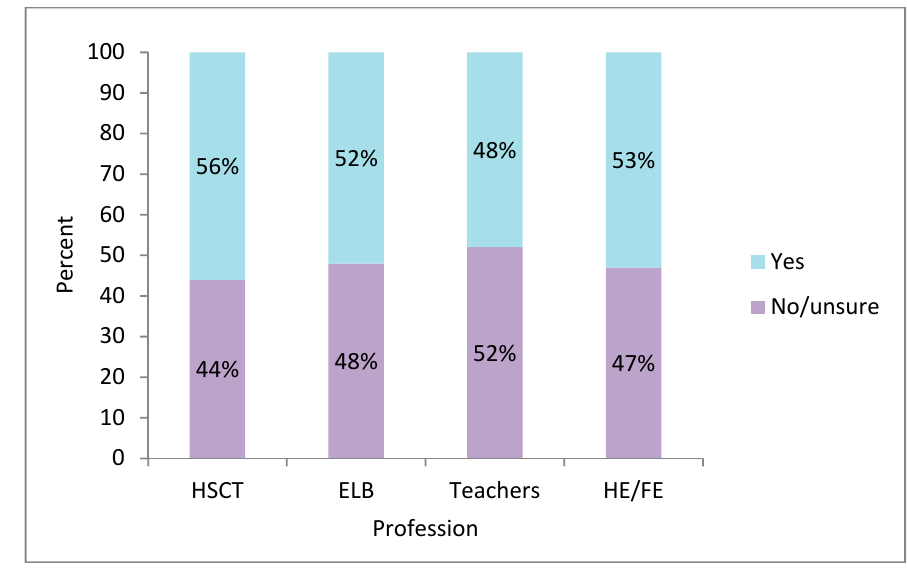
Figure 3. Personal knowledge of an individual with autism.